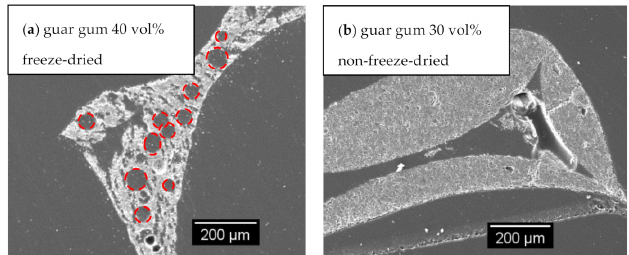
Figure 5. SEM micrographs of sintered foam samples ( a ) sample with guar gum, 40 vol.-% solid content and freeze-drying pores (holes from air bubbles marked with red circles), ( b ) sample with guar gum, 30 vol.-% solid content, conventionally dried at room temperature (pls. refer: [14]).